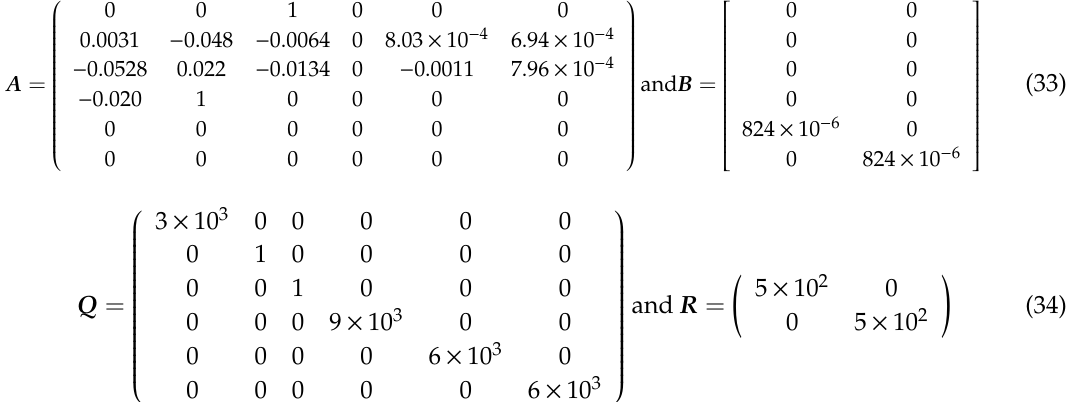
Figure 14. ( a ) Variation of the weight vs. time in both ballast tanks, ( b ) Variation of pitch angle with time, ( c ) Variation of sinking (heave) velocity with time and ( d ) Variation of depth with time in closed loop.